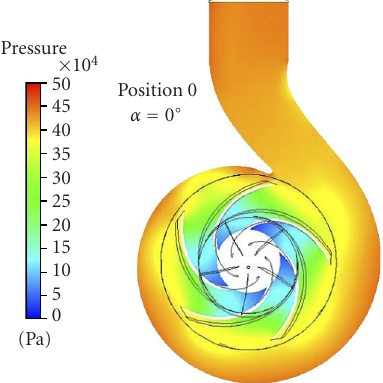
Figure 14: Static pressure field of pump NS32 at the best e ffi ciency point ( Q/Q bep = 1) and α = 0 ◦